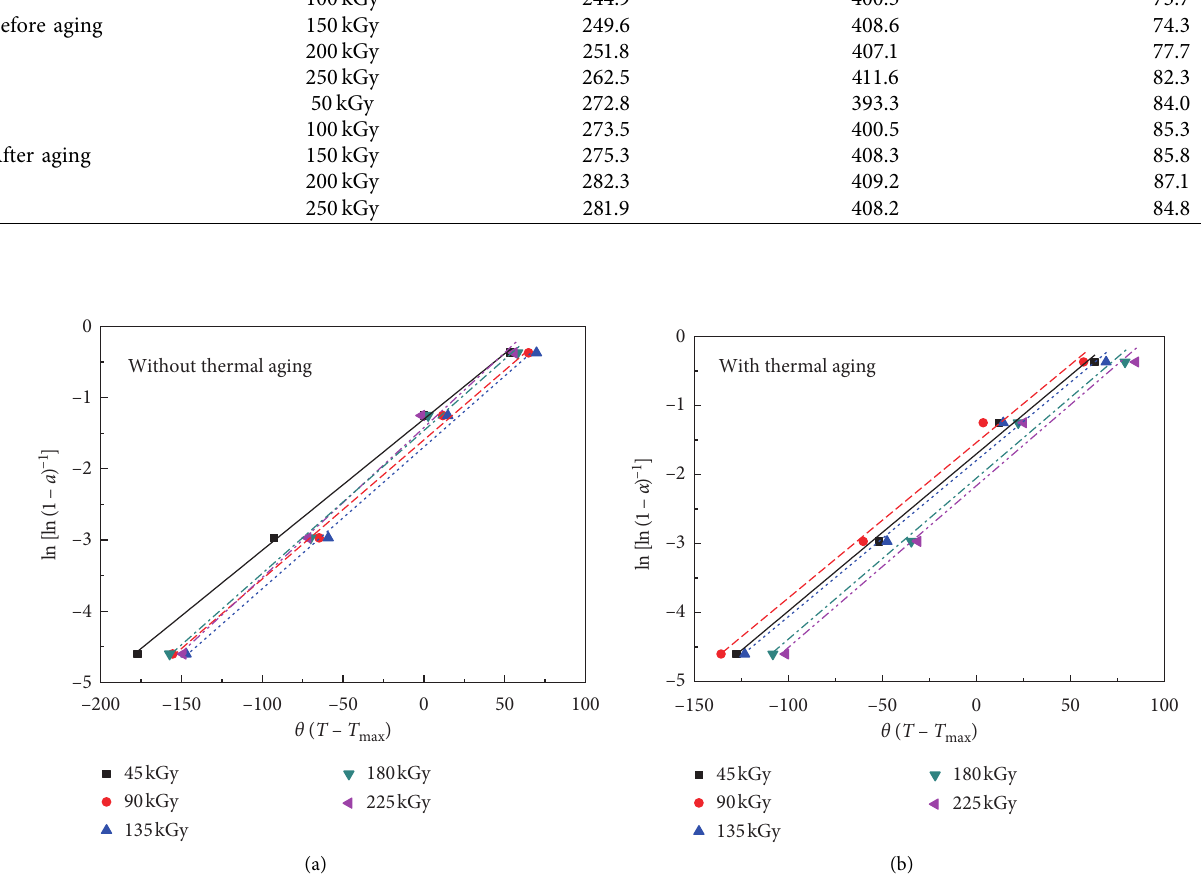
Figure 7: Plots of ln[ln(1 − α ) − 1 ] versus θ for the decomposition activation energy, non-aging and aging.